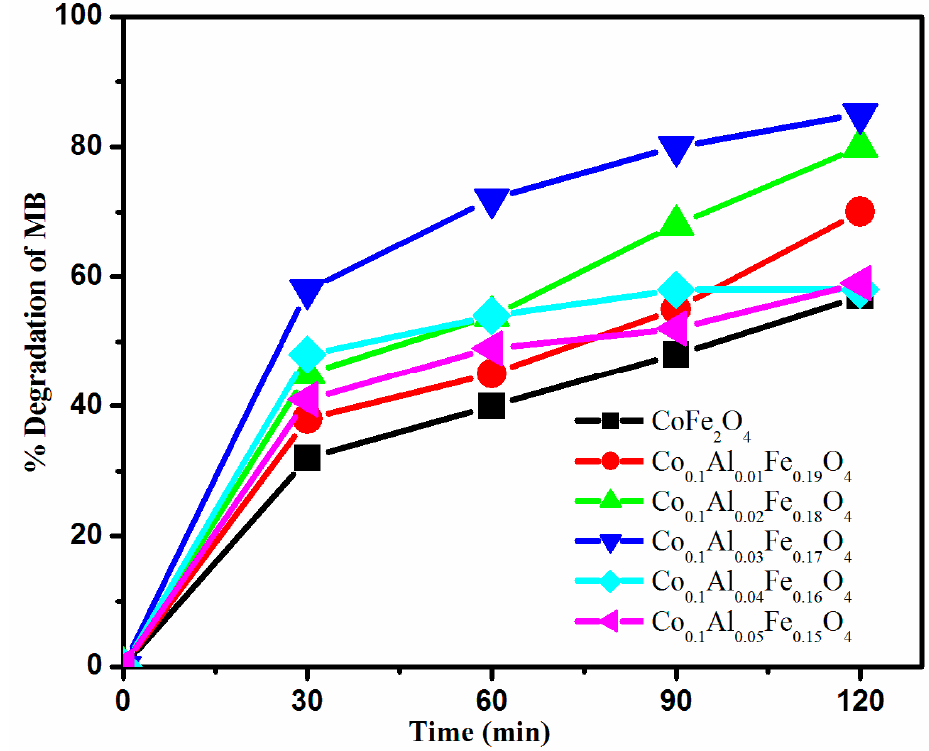
Figure 13. The plot of % Photodegradation of MB dye by different photocatalysts.